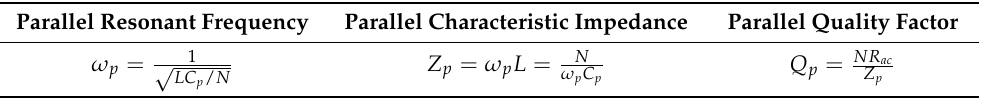
Table 1. Parameters of the LC p C s resonant